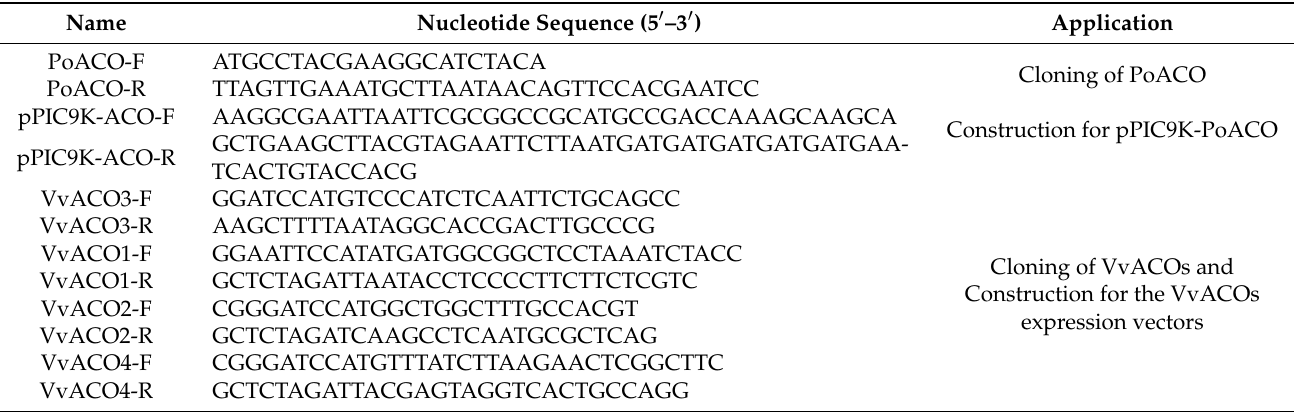
Table 1. List of primers used in the present